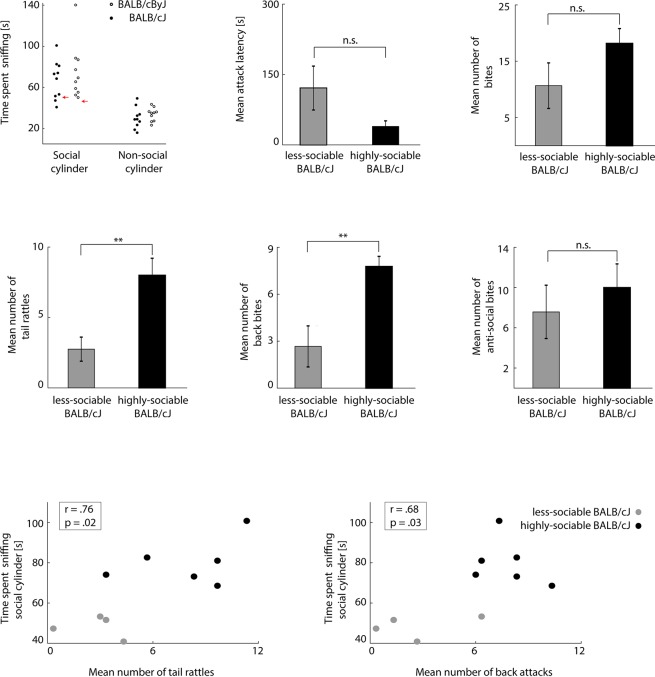
BALB/cJ mice can be split into two groups based on their sociability (A) Left panel: sniffing times of social and non-social cylinder in the 3CT test. Black dots: BALB/cJ mice. White dots: BALB/cByJ mice. Red arrows indicate average + 2 standard deviations of non-social cylinder sniffing time. Middle and right panel: average attack latency and number of bites of sociable and less-sociable BALB/cJ mice. Black bar: sociable BALB/cJ mice. Gray bar: less-sociable mice. Error bars: standard error of the mean (SEM). (B) Same as
Figure 1B
, but for sociable (black) versus less-sociable BALB/cJ mice (gray). (C) Correlation between social cylinder sniffing time and socially acceptable bites (left panel: tail rattles, right panel: back bites). Black dots: sociable BALB/cJ mice. Gray dots: less-sociable BALB/cJ mice. **p < .01; n.s. = not significant.